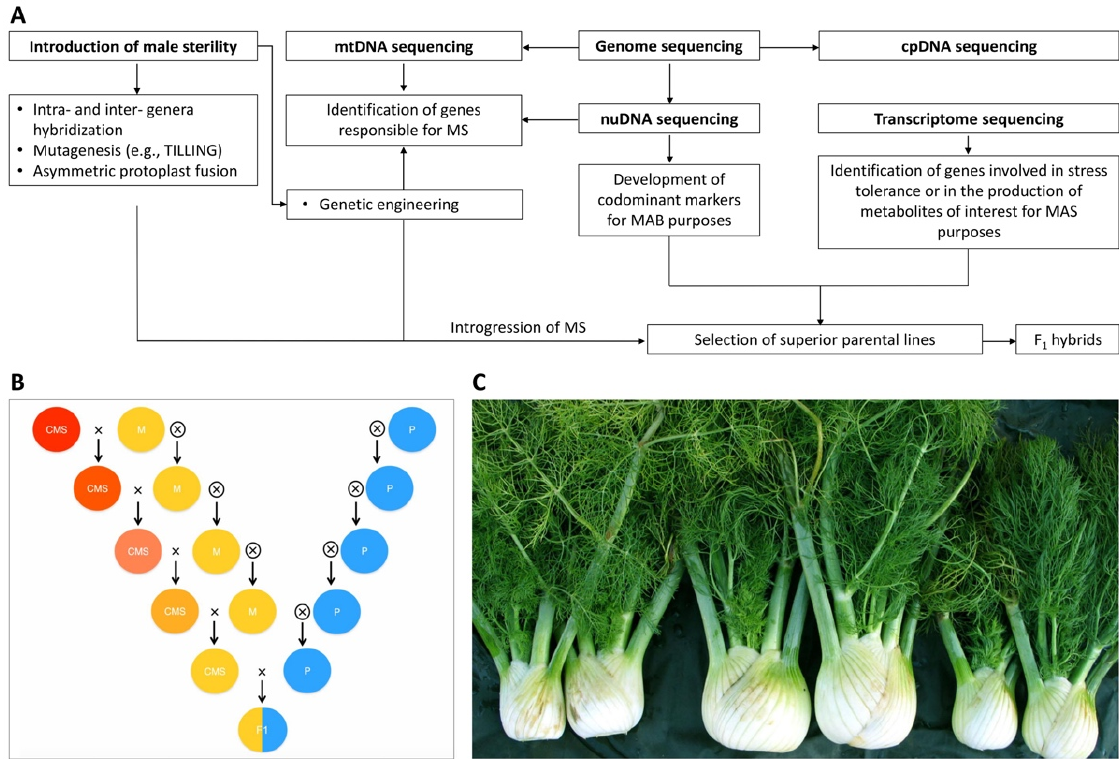
Figure 5. ( A ) Synoptic flowchart summarizing the impact of male sterility systems, genomic and transcriptomic resources on breeding strategies. ( B ) Breeding methods exploitable for the selection of CMS inbred lines morphological similar to maintainers (M) and genetically differentiated to pollinators (P) used for the development of F1 hybrids in fennel ( × , sibling; ⊗ , selfing). ( C ) Example of fennel commercial products of F1 hybrids (center) with parental plants, i.e., female male sterile inbred line (left) and male inbred line (right) (source: courtesy of Dr. Luca Pallottini).